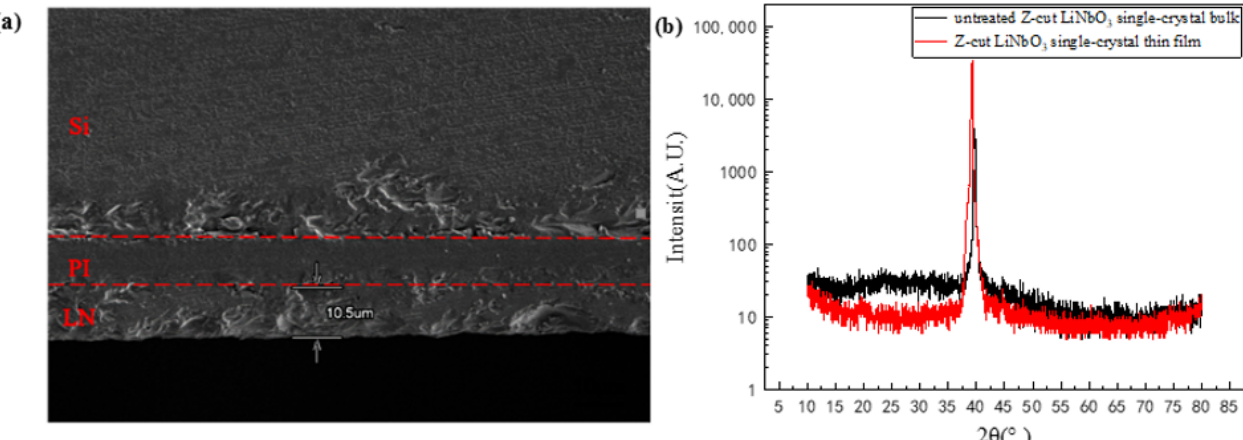
Figure 7. ( a ) Scanning electron microscope (SEM) image and ( b ) X-ray diffraction (XRD) pattern of the LiNbO 3 single-crystal thin film integrated on